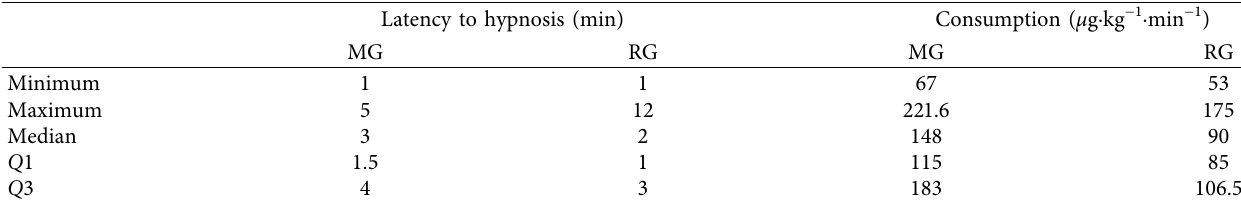
Figure 3: Comparison of ephedrine consumption between the groups. MG, magnesium sulfate group; RG, remifentanil group. Table 4: Comparison of latency to hypnosis and consumption of propofol between the groups.